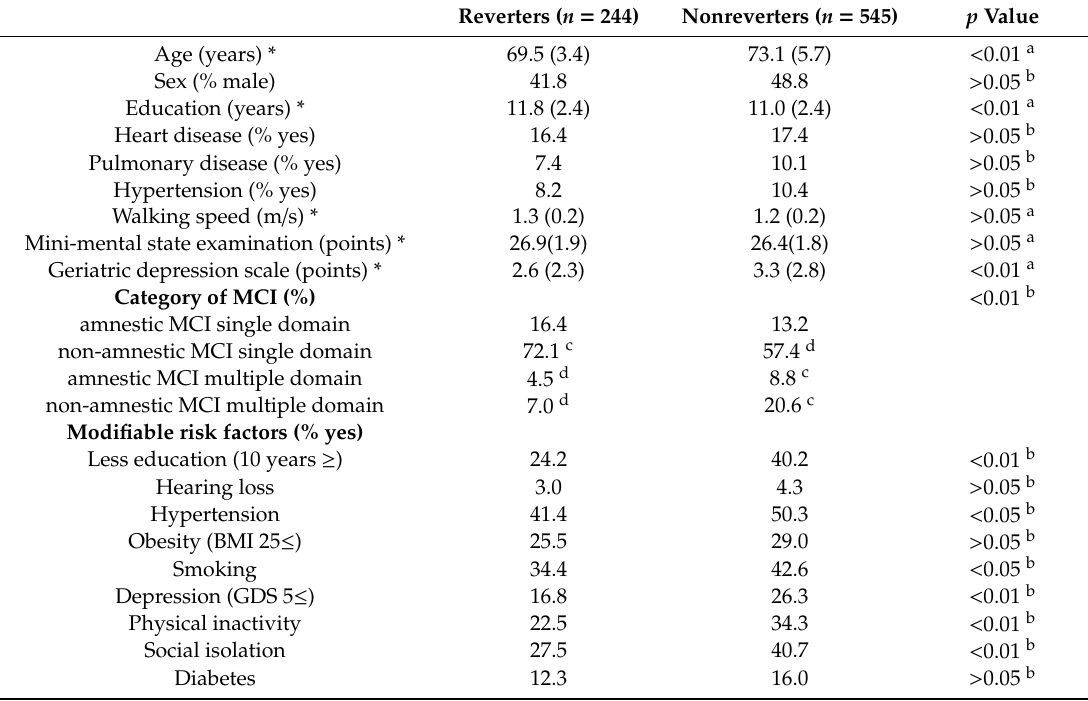
Table 1. Comparison of baseline characteristics between reverters and